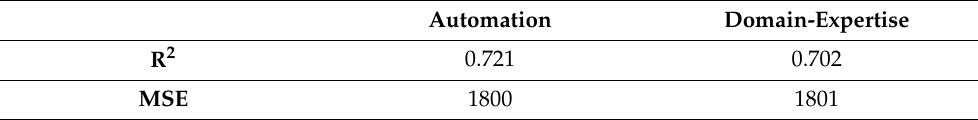
Table 2. Difference in pre-processing between automation and domain expertise in